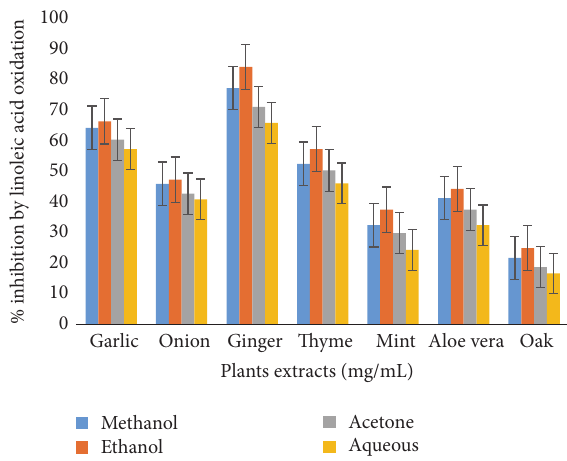
Figure 4: Percentage inhibition of linoleic acid